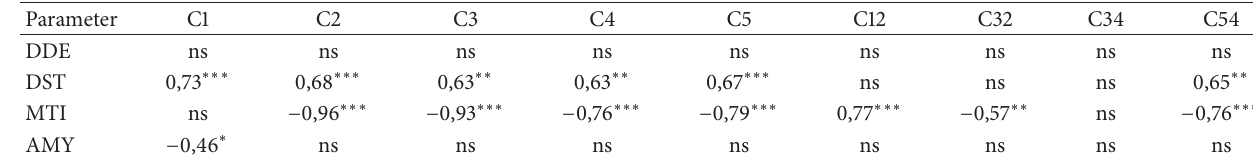
Table 3: Correlation analysis between mixolab, farinograph and amylograph test